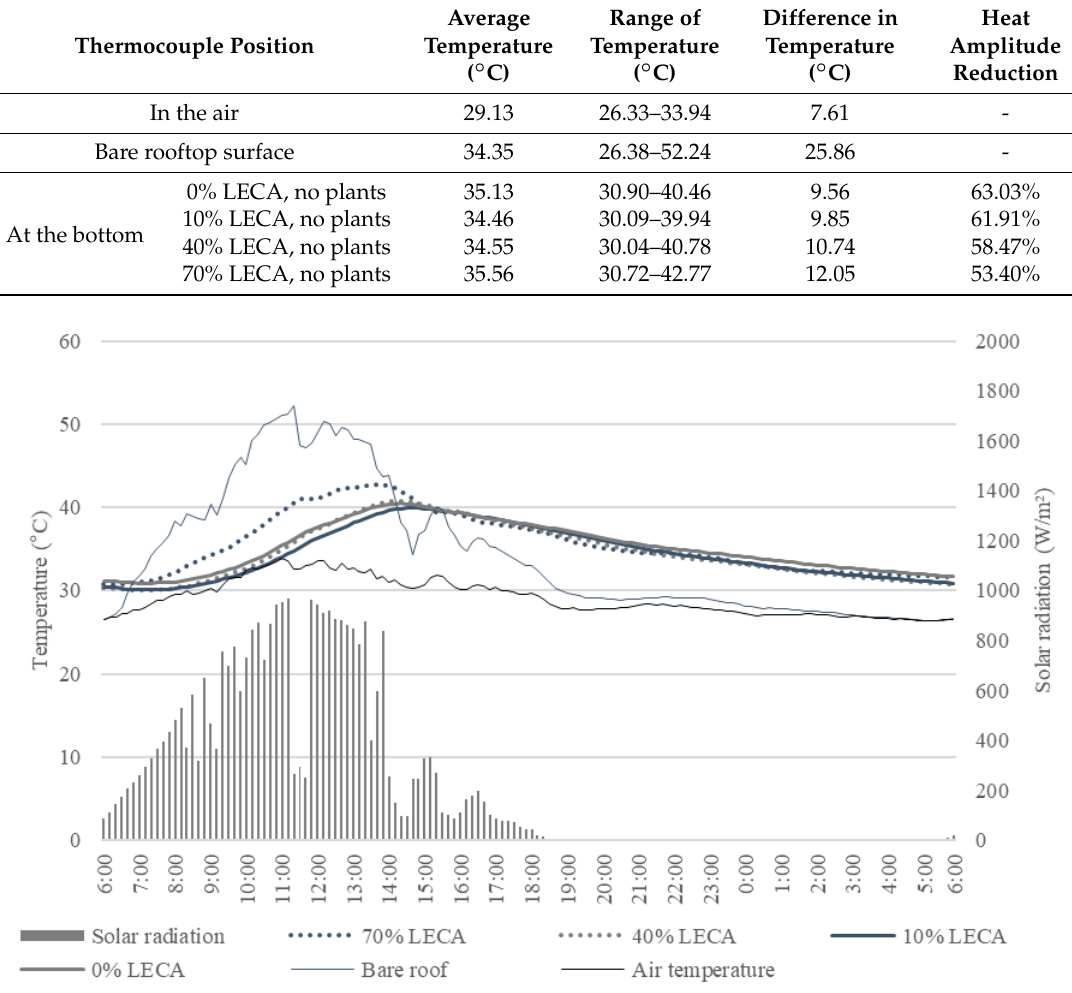
Figure 11. Temperatures and solar radiation in the cases of roofs with 0%, 10%, 40%, and 70% LECA laid at the bottom without plants (25 July 2017 06:00:09 to 26 July 2017 05:50:09). 3.3. Temperature Reduction W hen 10% and 40% LECA were Laid at the Bottom without Plants and when